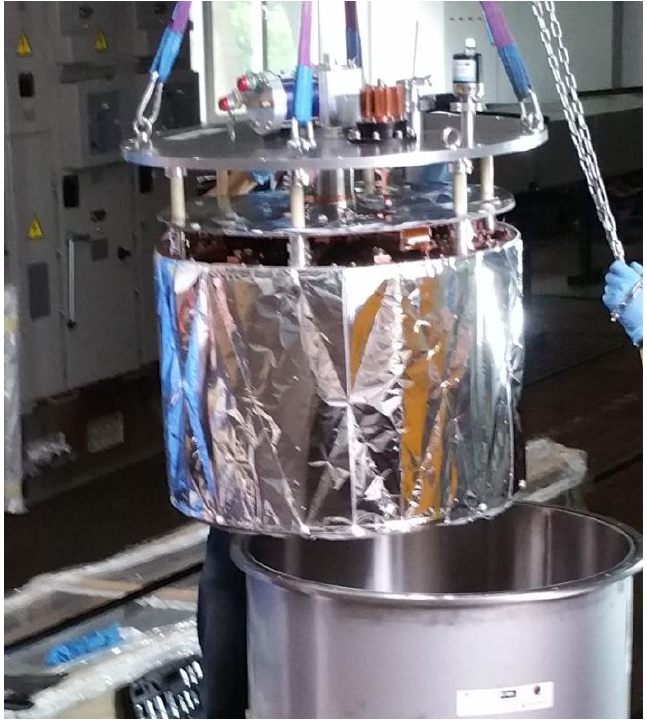
Figure 3. Superconducting fault current limiter assembly in a cryostat [38].